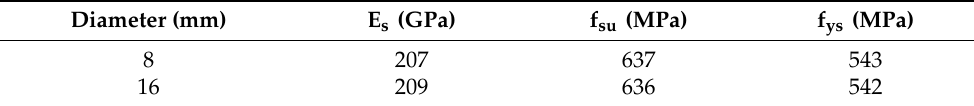
Table 3. Mechanical characteristics of steel reinforcement [48].